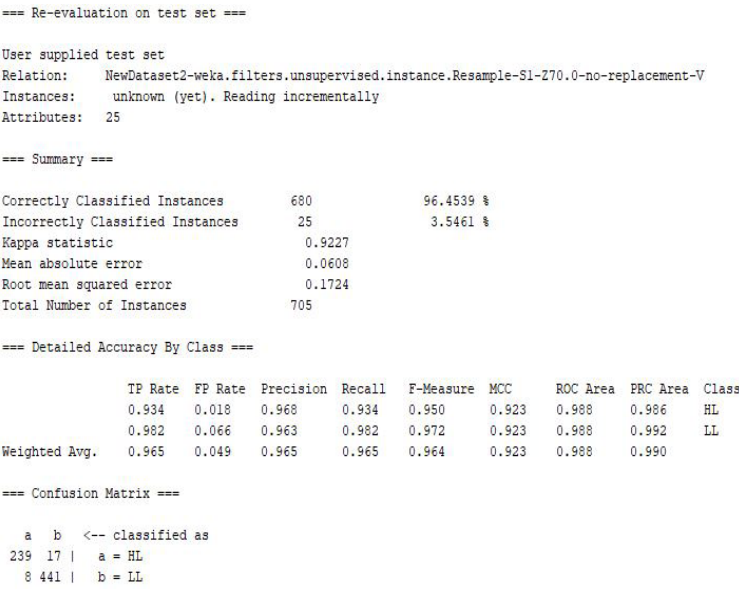
Figure 8: Logistic regression (LR) model for testing